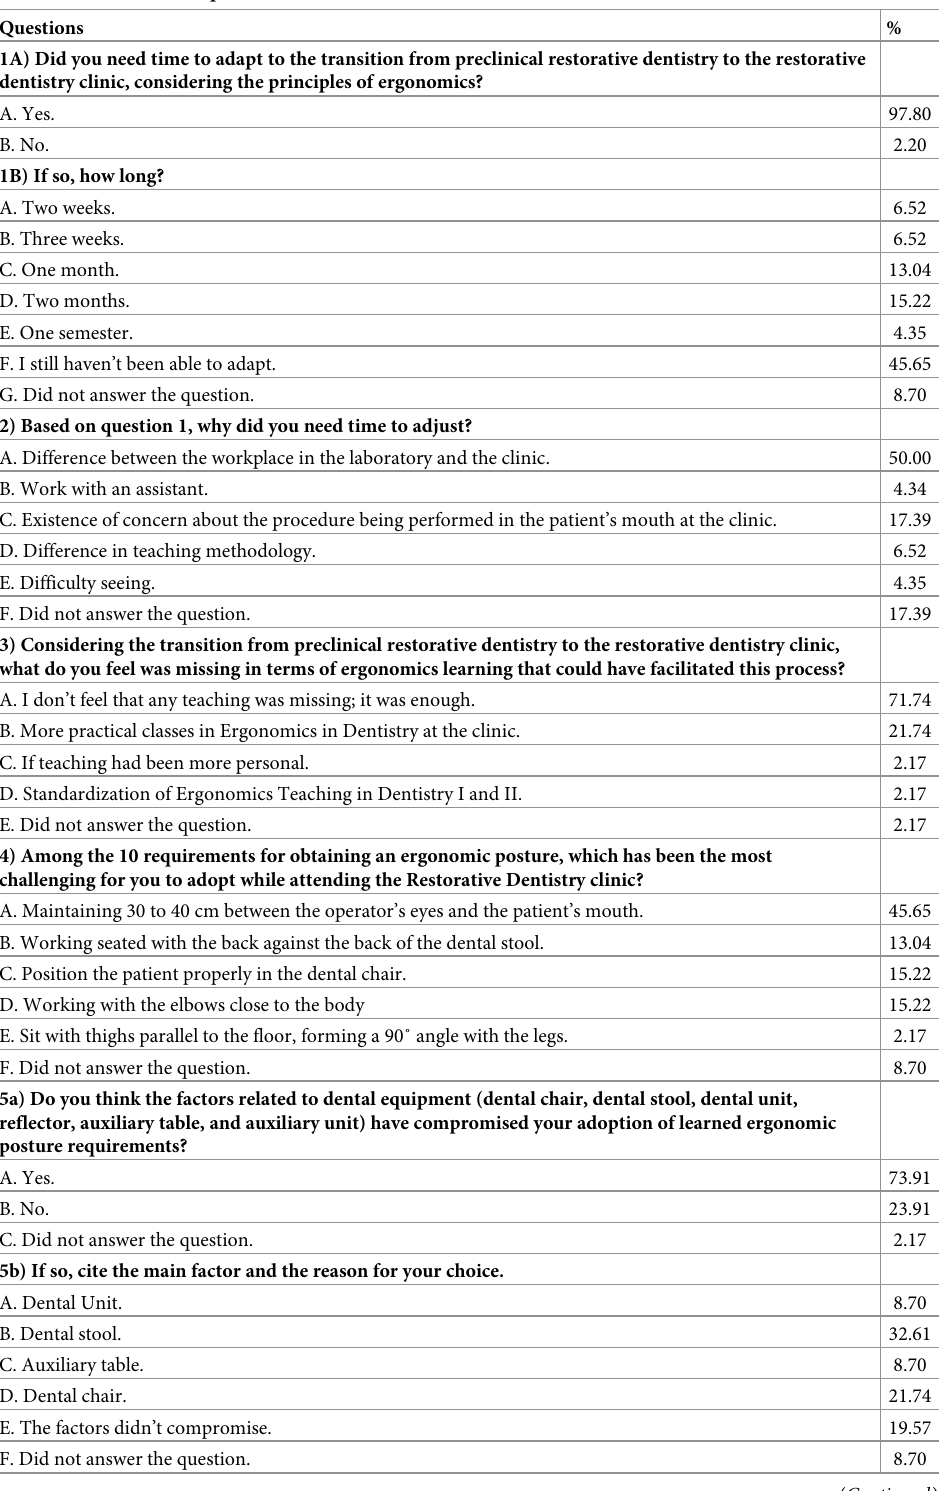
Table 1. Summary of the Discourse of the Collective Subject (DCS) questionnaire results organized by the catego- ries associated with each